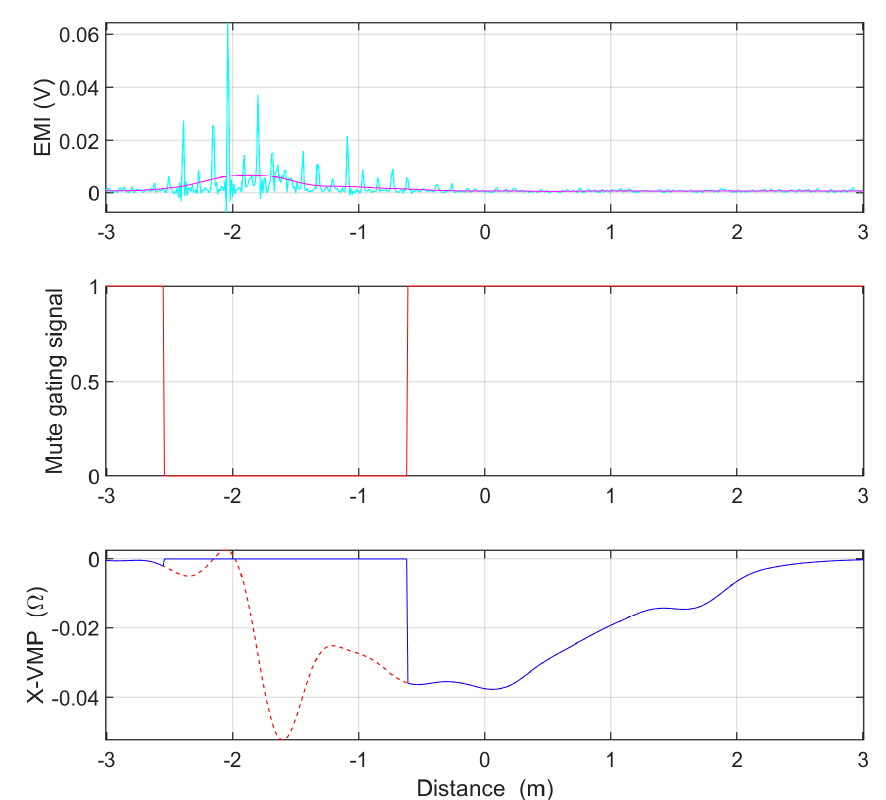
Figure 4. Example operation of the mute function. The oscillations in X-VMP (dashed red line) caused by EMI have been effectively muted.